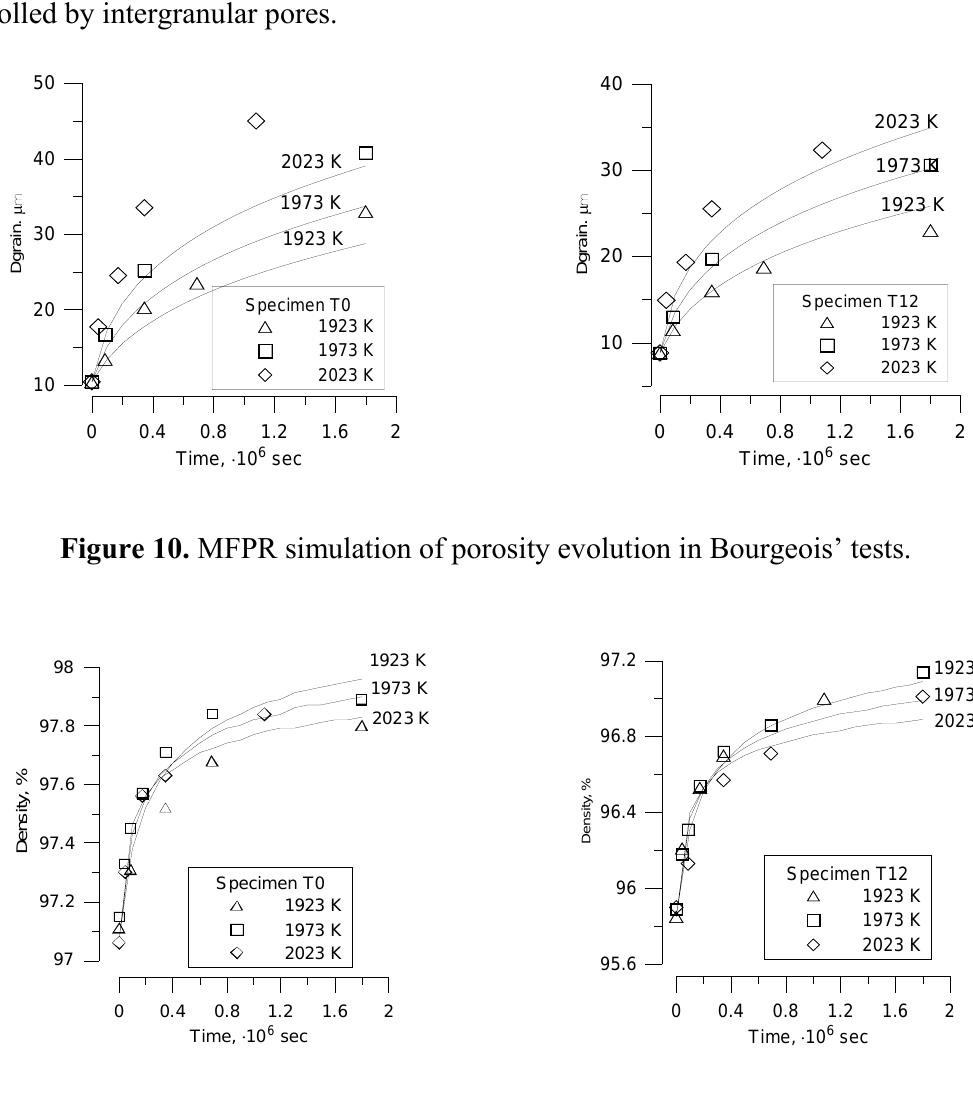
Figure 9. MFPR simulations of Bourgeois’ tests. New model for normal grain growth controlled by intergranular pores.